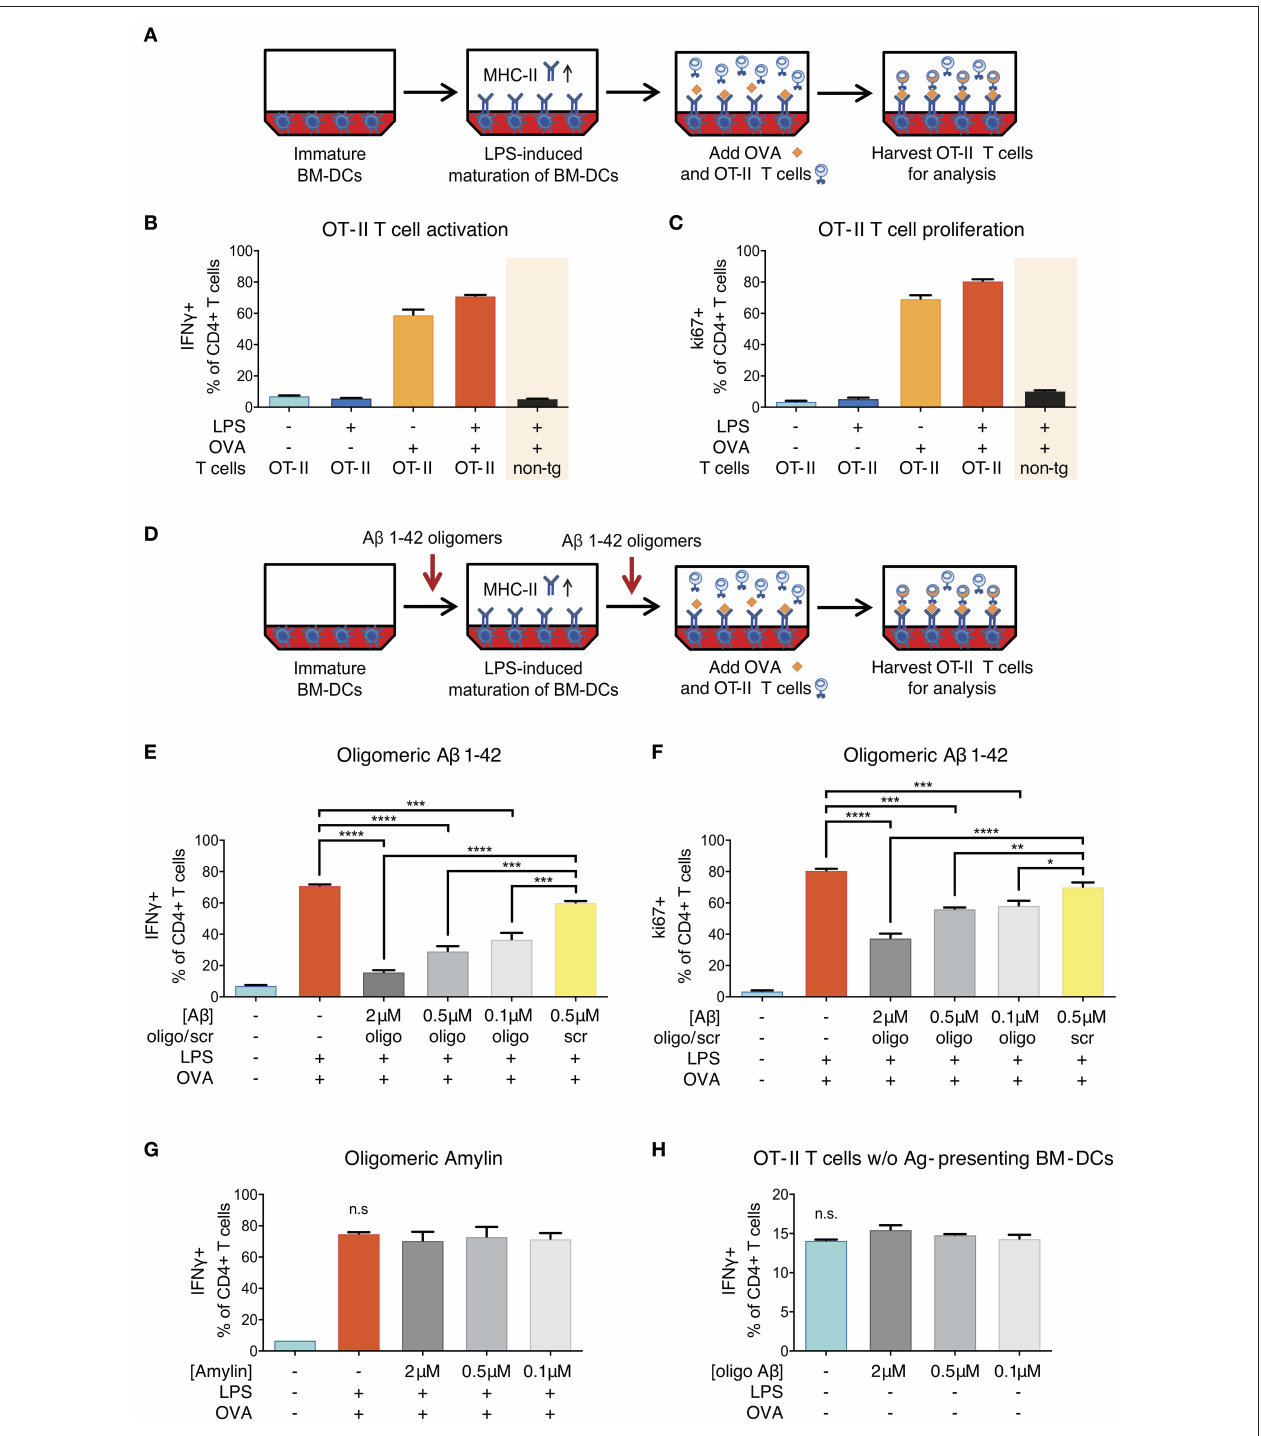
FIGURE 4 | Reduction of ovalbumin (OVA)-specific OT-II T-cell response following A β 1-42 oligomer treatment. (A) Schematic of in vitro antigen presentation assays. LPS-matured bone marrow-derived dendritic cells (BM-DCs) process full-length ovalbumin (OVA) and present antigenic material. OVA-specific OT-II tg CD4 + T-cells are added to the BM-DCs and co-incubated for 40h. IFN γ and ki67 are analyzed in harvested T-cells via flow cytometry as markers of T-cell activation and proliferation, respectively. Full activation (more IFN γ + cells) (B) and proliferation (more ki67 + cells) (C) of T-cells specifically requires the presence of mature BM-DCs (treated with LPS) and OVA-derived antigens. T-cell activation is antigen-specific and does not occur in the absence of OVA, nor if non-tg CD4 + T-cells are used instead of OVA-specific OT-II CD4 + T-cells. (D) The effect of A β is tested by incubating immature BM-DCs with human recombinant A β 1-42 (oligomeric state)